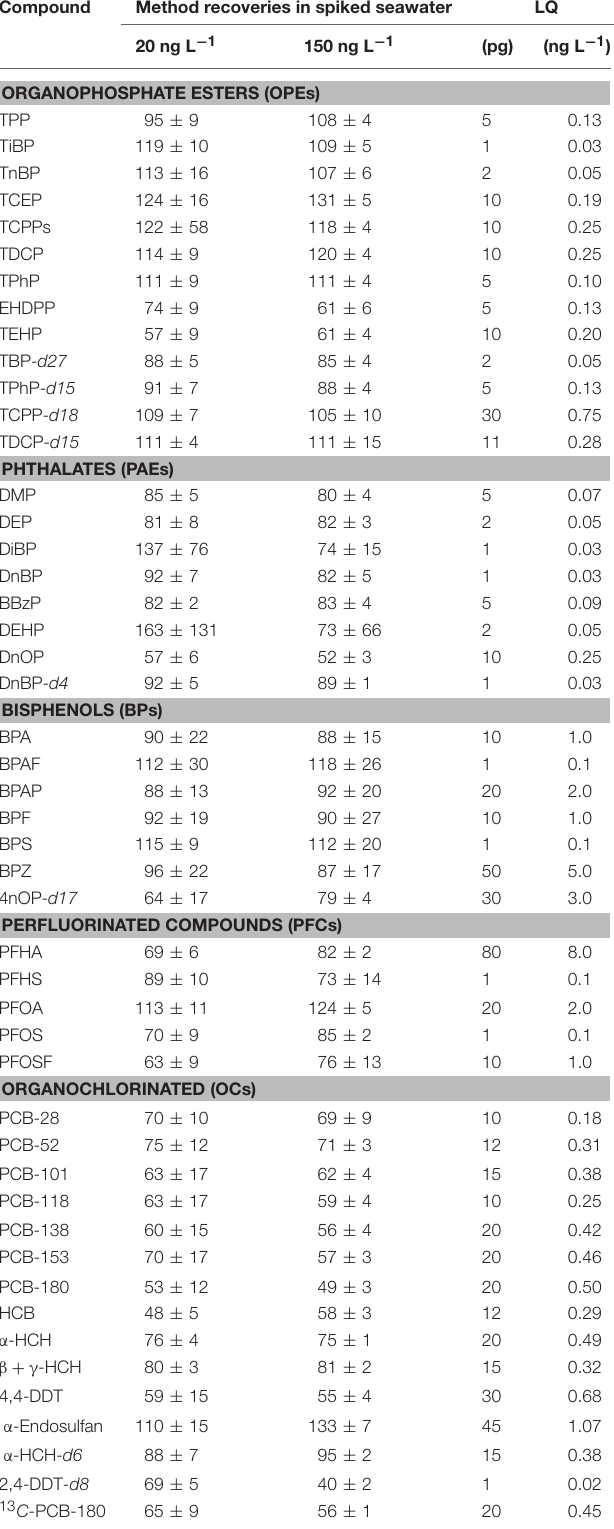
TABLE 3 | Recoveries of the target contaminants ( n = 5) with their associated standard deviation, LQs expressed as absolute amounts (pg) and ng L − 1 in